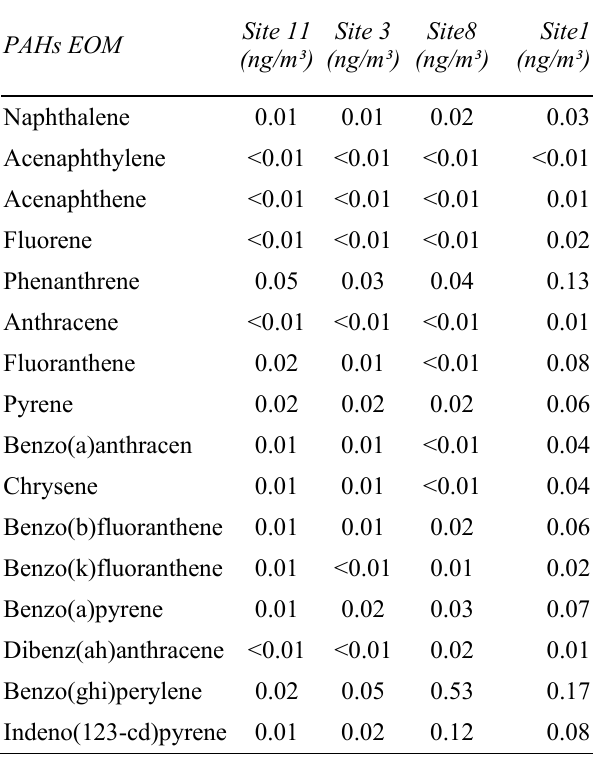
Table 2: PAHs content in the PM10 EOM samples from four monitoring sites in Jeddah, Saudi Arabia.